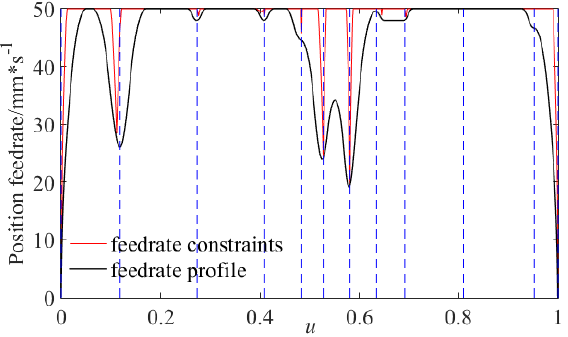
Figure 11. Feedrate profile of the tool-tip position with respect to curve parameter.